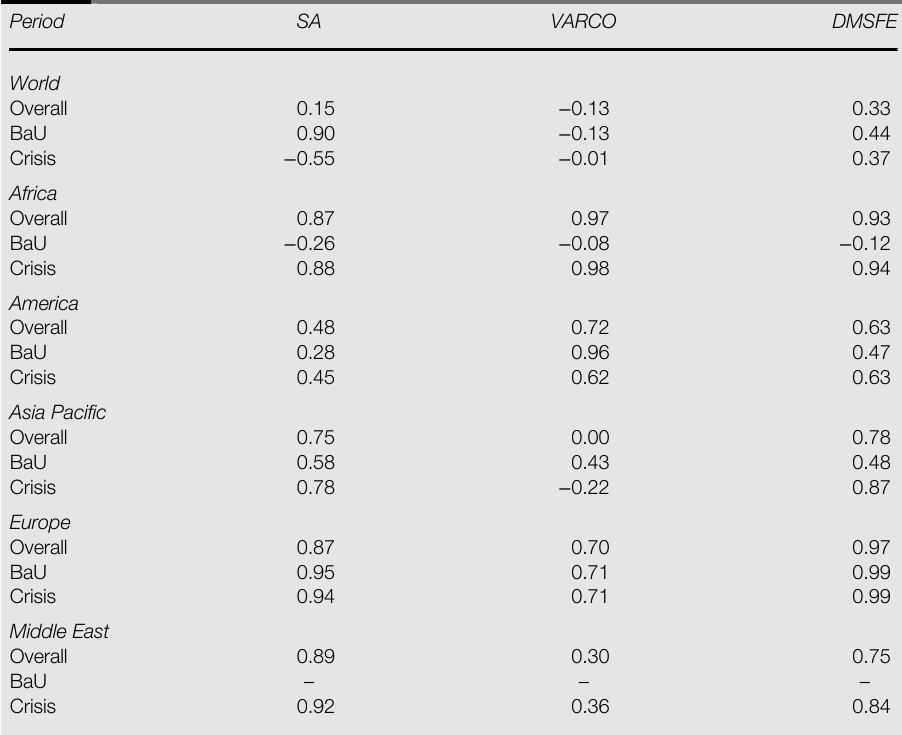
Table II Forecast error series correlation (combination model against best performing